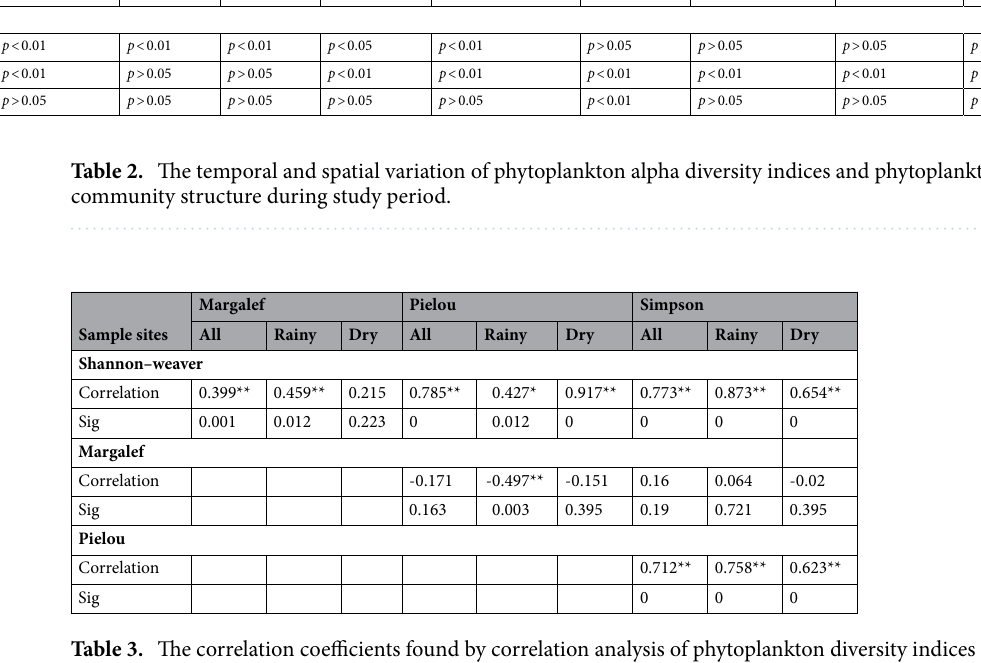
Table 3. The correlation coefficients found by correlation analysis of phytoplankton diversity indices and TSI in All samples, Wetland samples (S01–S10), River samples (S11–S17) in different hydro periods. *Denotes p < 0 .05 (two-tailed), **Denotes p < 0 .01